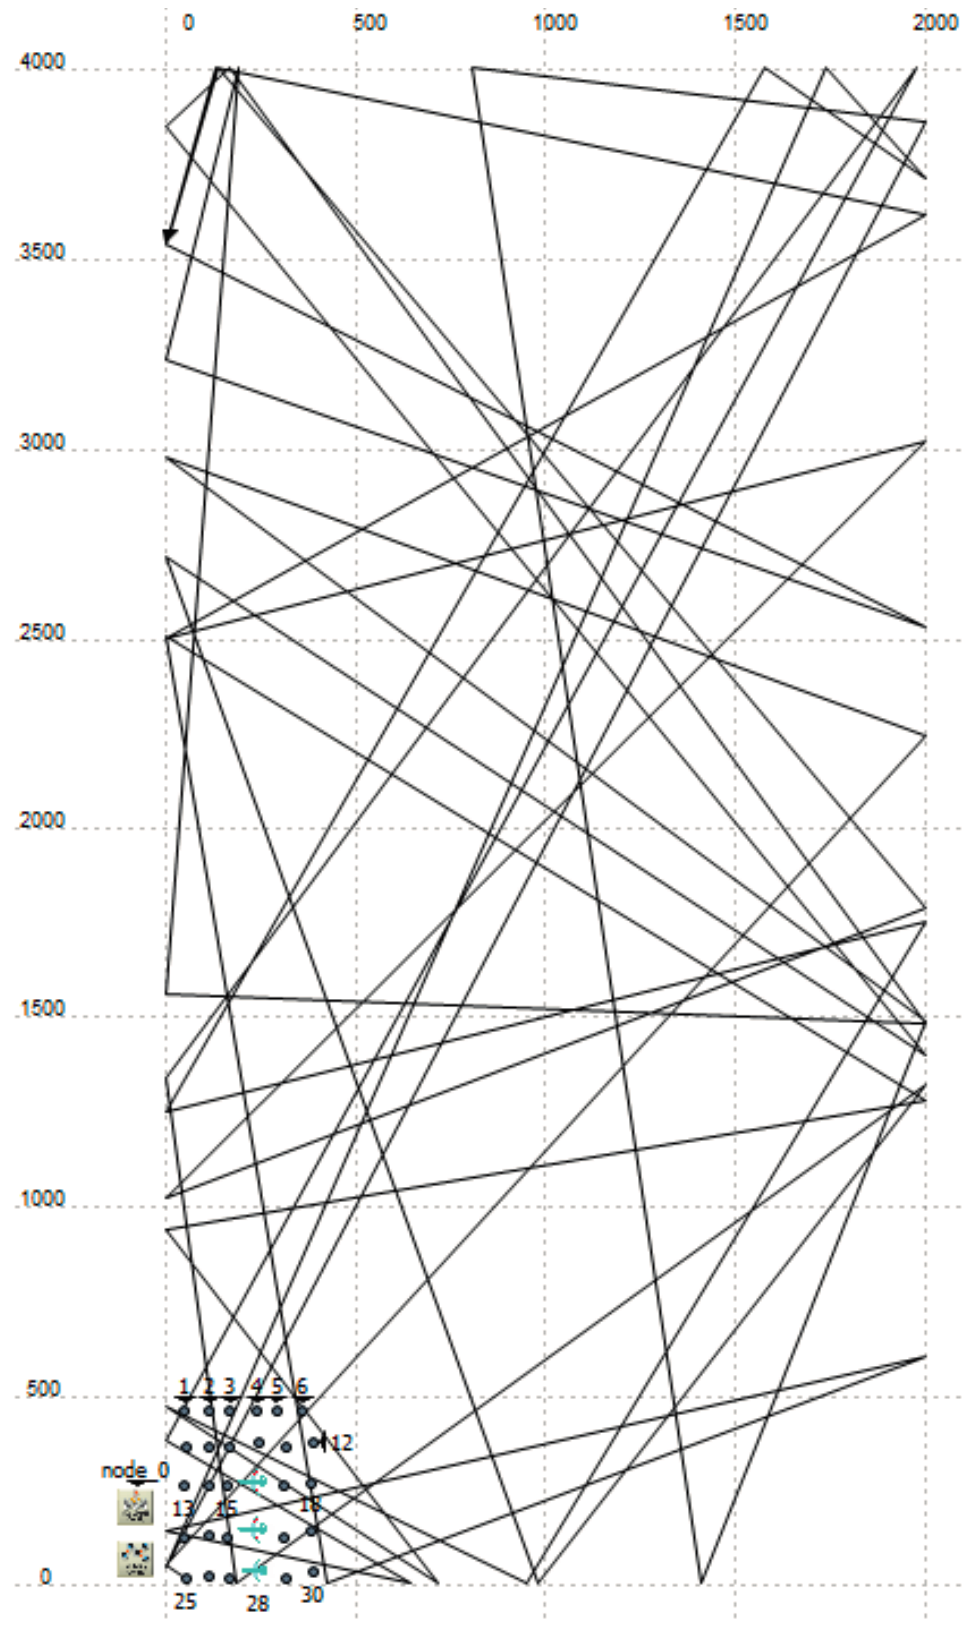
Figure 2. Trajectory of a UAV under the random direction (RD)